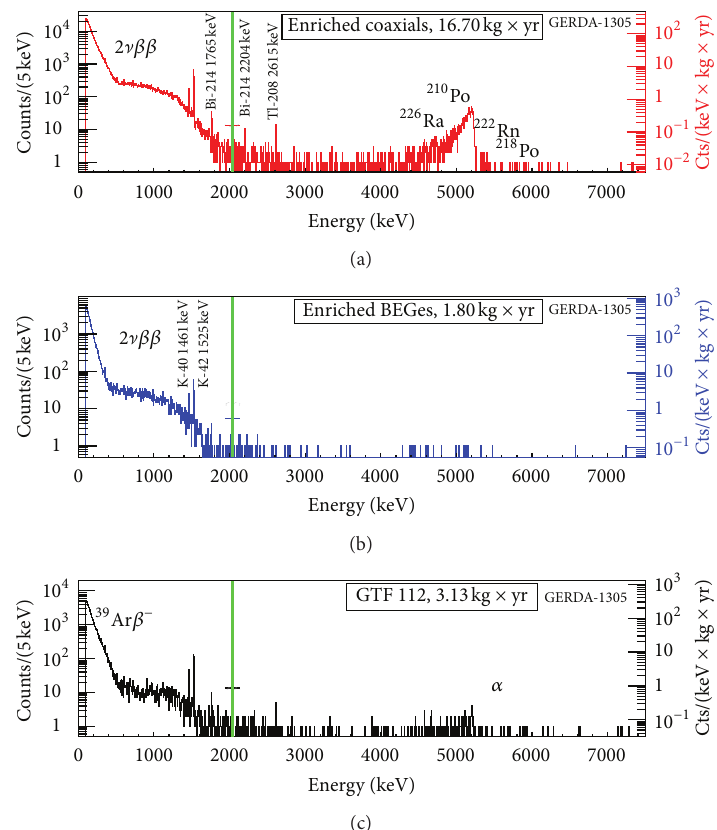
Figure 5: Spectra obtained using all the enriched semicoaxial (a), BEGe (b), and nonenriched (c) detectors. The blinding window of 40keV around the 𝑄 𝛽𝛽 is indicated with the green band. The bars in the color of the histogram around the green band represent the 200 keV region from which the BI of the dataset is computed. From [28].